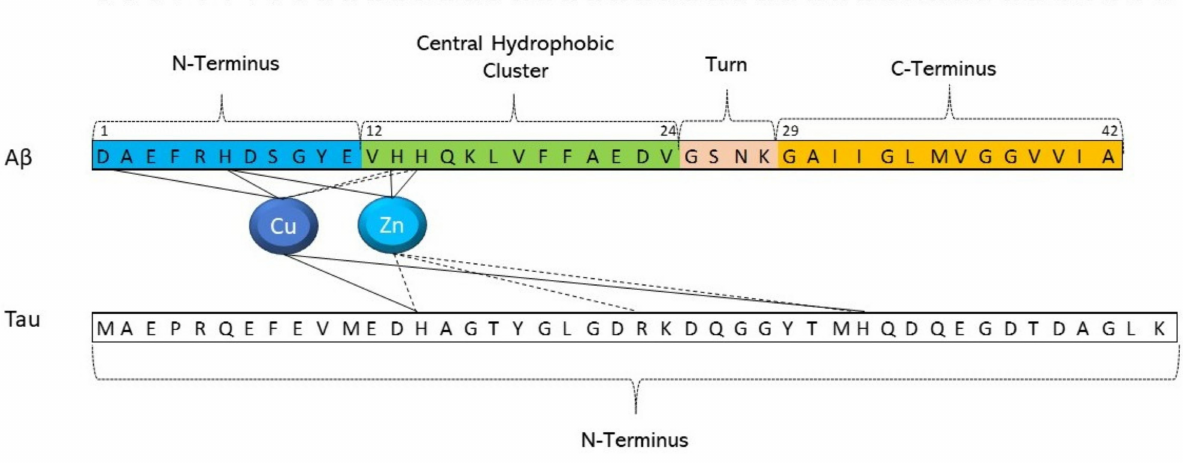
Figure 2. Cu(II) and Zn(II) binding sites in tau and A β peptide